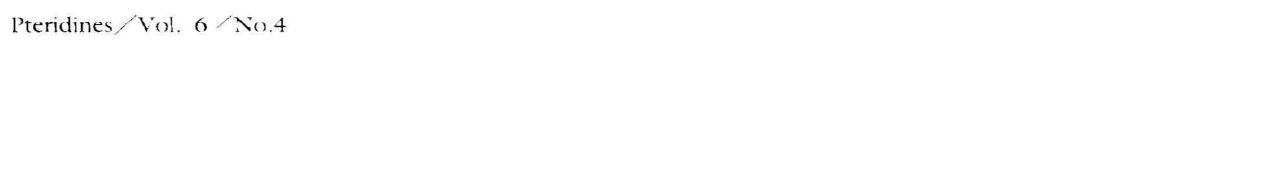
Pteridines/ Vol. 6 /~()